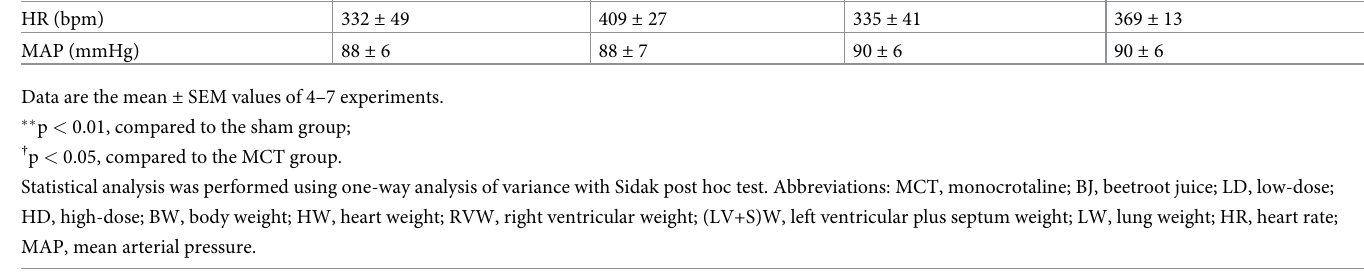
Data are the mean ± SEM values of 4–7 experiments. �� Statistical analysis was performed using one-way analysis of variance with Sidak post hoc test. Abbreviations: MCT, monocrotaline; BJ, beetroot juice; LD, low-dose; HD, high-dose; BW, body weight; HW, heart weight; RVW, right ventricular weight; (LV+S)W, left ventricular plus septum weight; LW, lung weight; HR, heart rate; MAP, mean arterial pressure.